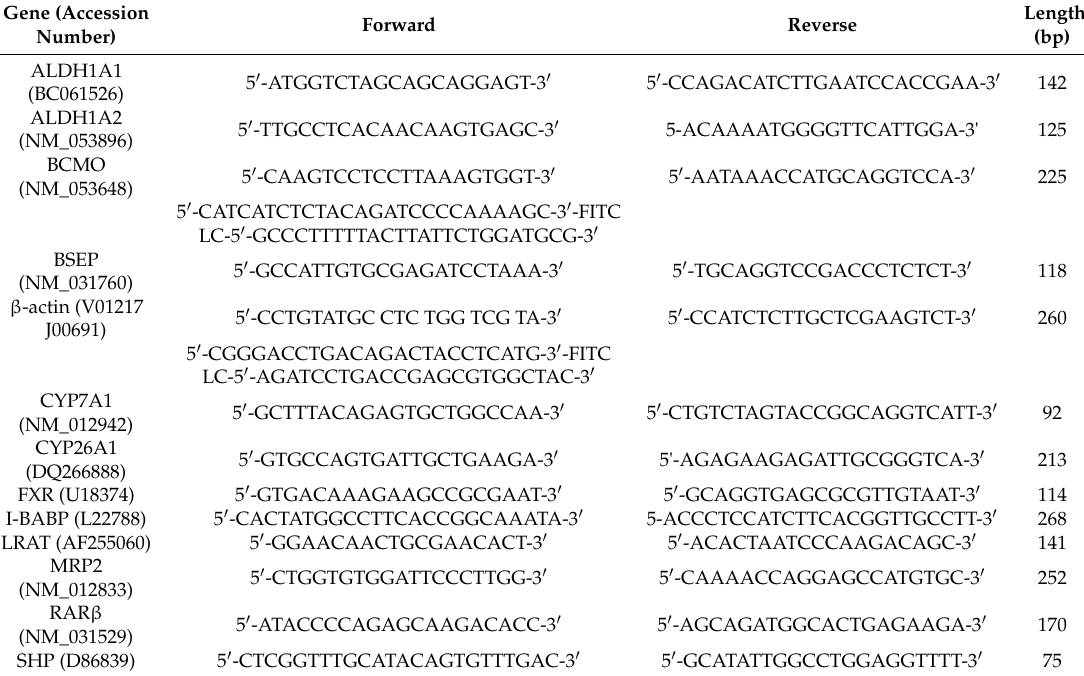
Table 2. Sequences of oligonucleotide primers for real-time